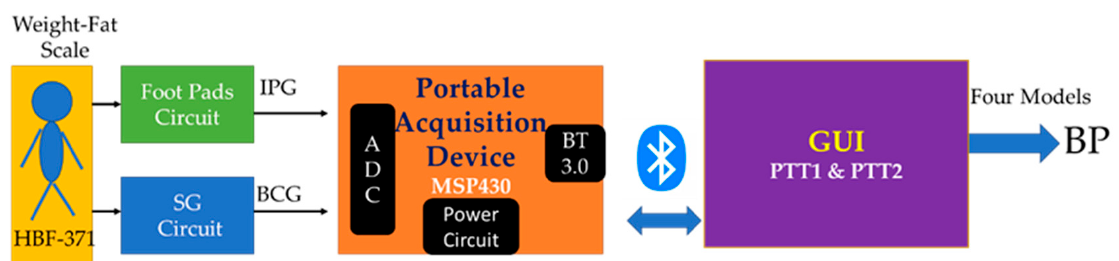
Figure 1. The structure of the minimal contact blood pressure measurement method.